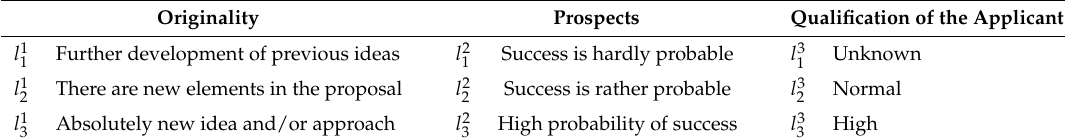
Table 10. Criteria and OQSs for evaluating the R&D